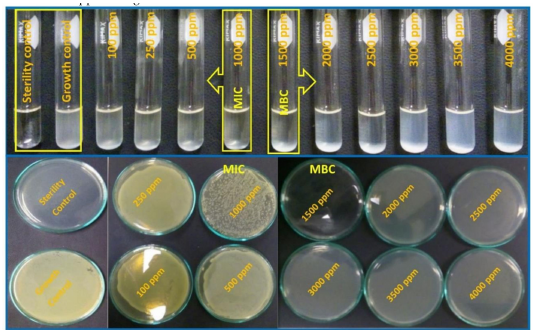
Figure 10. Escherichia coli ATCC 25,922 exposed to different concentrations of MgO NPs. The test tubes’ turbidity from 3000 to 4000 ppm was associated with the scattering of MgO NPs. On the upper photographs, the Petri dishes show that for concentrations of 500 ppm and below, the growth was the same as in the growth control. MIC: 1000 ppm; MBC: 1500